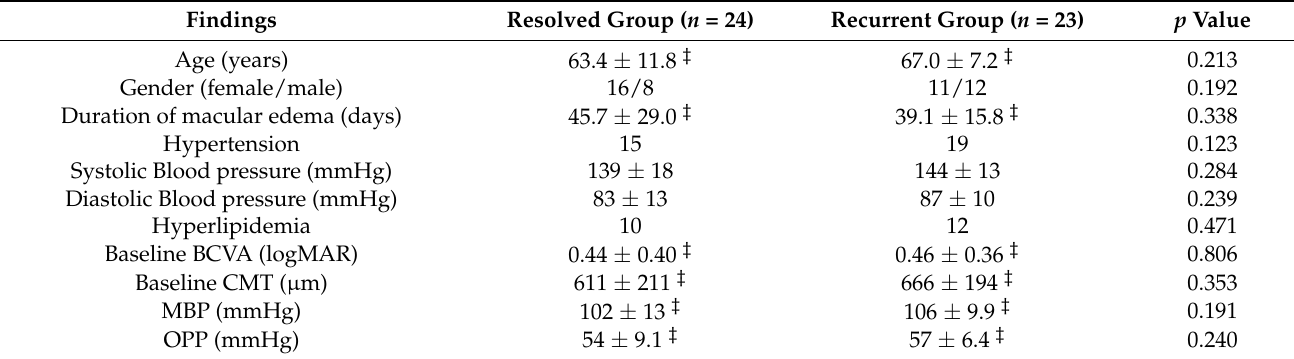
Table 1. Baseline clinical features of the resolved and recurrent groups.